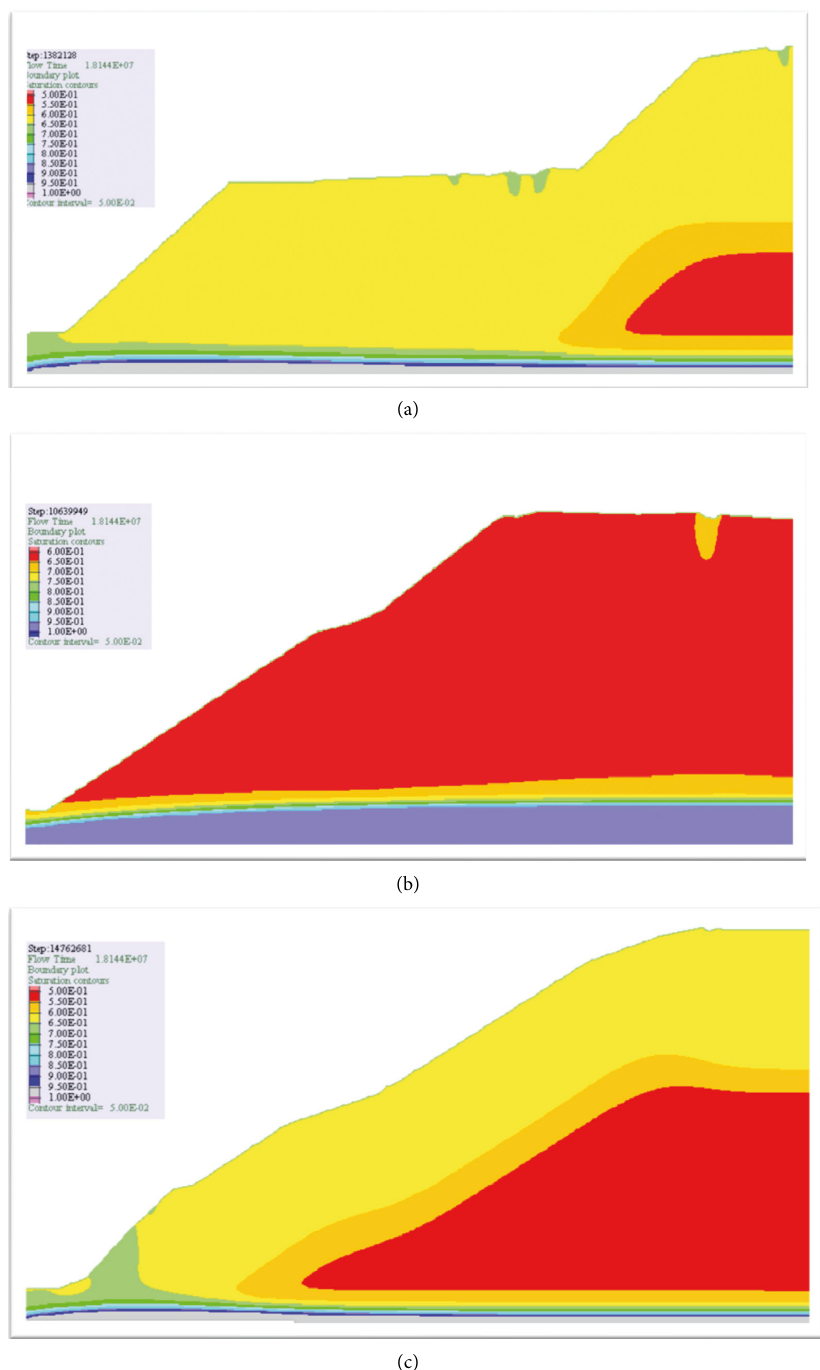
Figure 15: (a–c) represent the saturation profiles of section 1, section 2, and section 3, respectively, with a flow time of 7